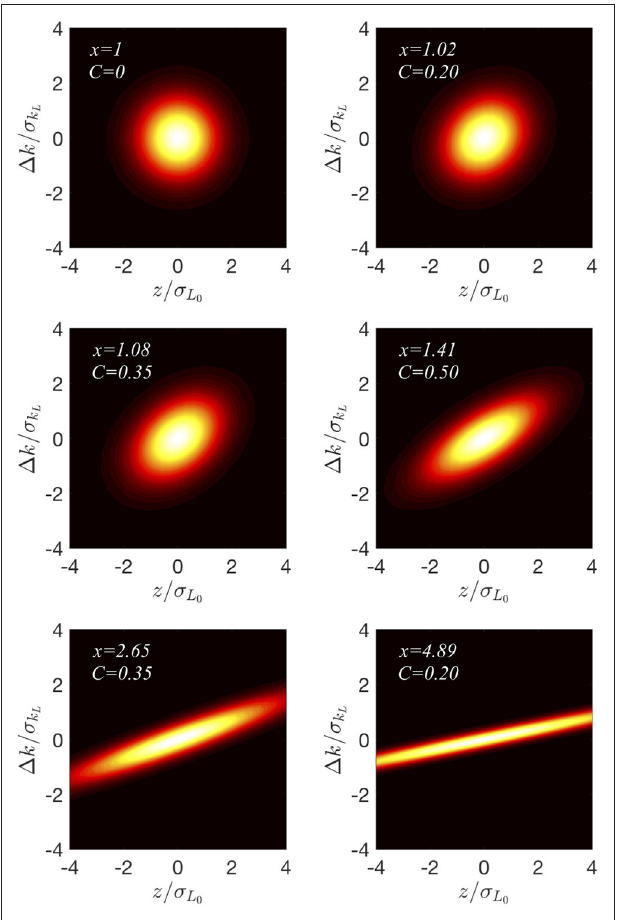
FIGURE 9 | Wigner distributions of a chirped laser pulse with fixed bandwidth with x and C values from Equation (36).